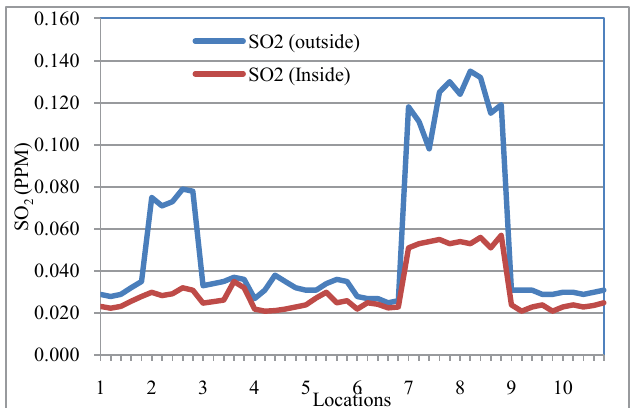
Fig. 4: Monitored SO 2 Concentrations Inside and Outside of Houses 10 Locations in the Study Area